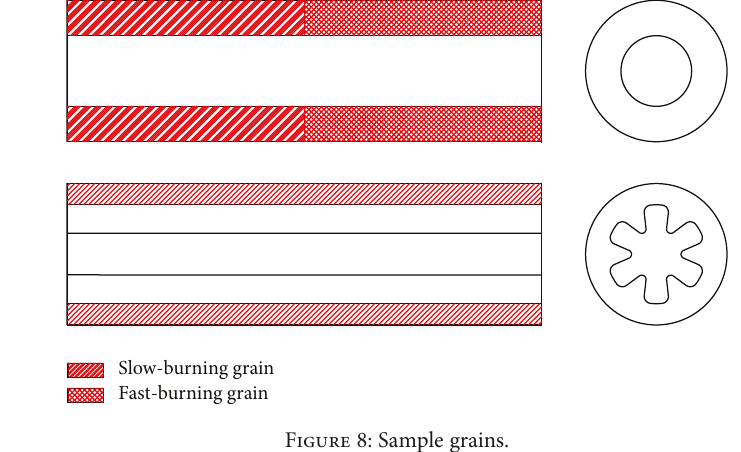
Figure 8: Sample grains.